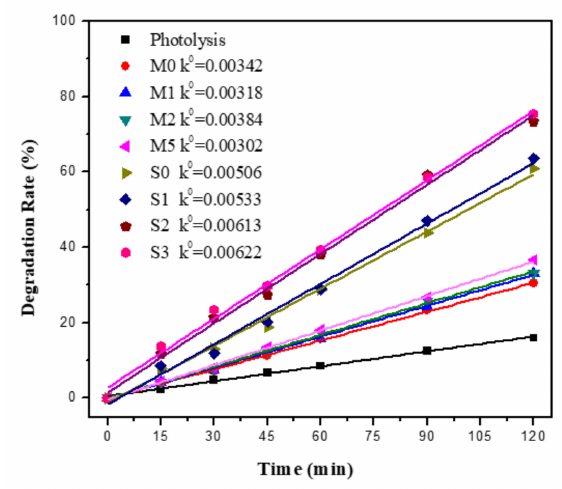
Figure 9. Degradation rate of methylene blue and photocatalytic reaction rate of photocatalytic mortar blocks under solar light.